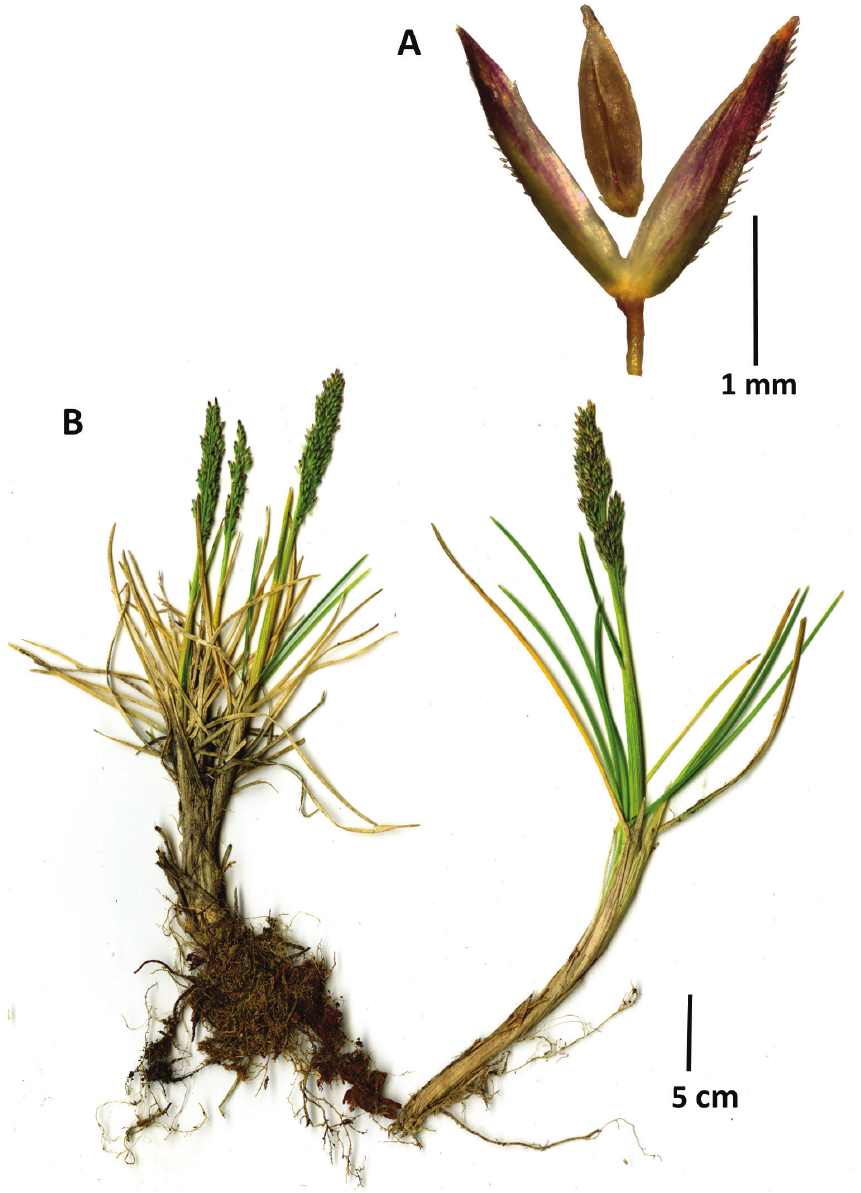
Figure 3. Agrostis breviculmis A spikelet, glumes in lateral view, floret in ventral view, detached and raised above the glumes B whole plant. Images of Cuta-Alarcon 364 (FMB).